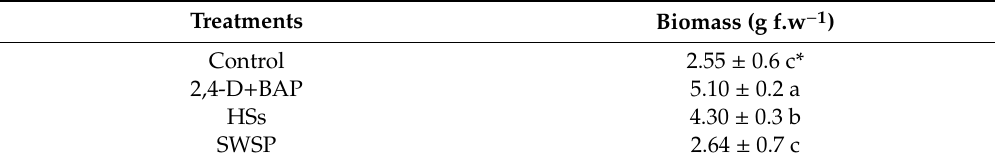
Table 2. Biomass (g) of Pinus laricio callus after 28 d of subculture in presence of hormones or humic